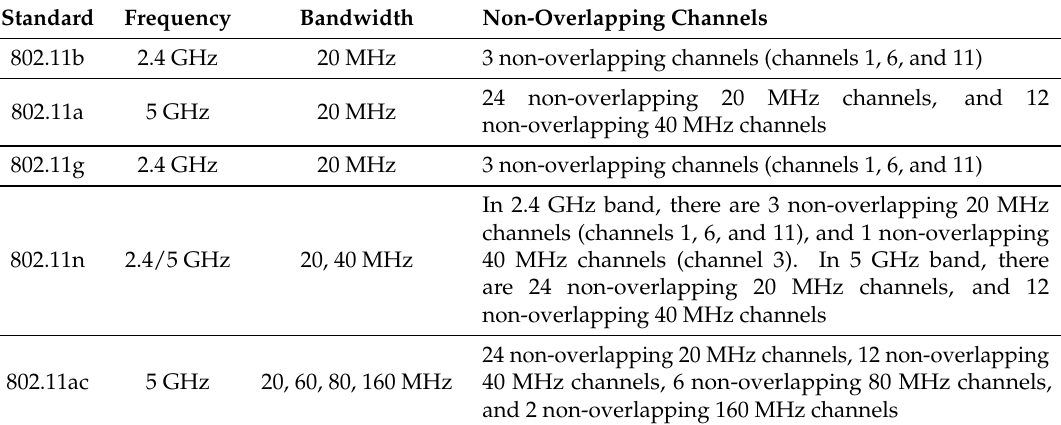
Table 1. IEEE 802.11 standards and non-overlapping channels